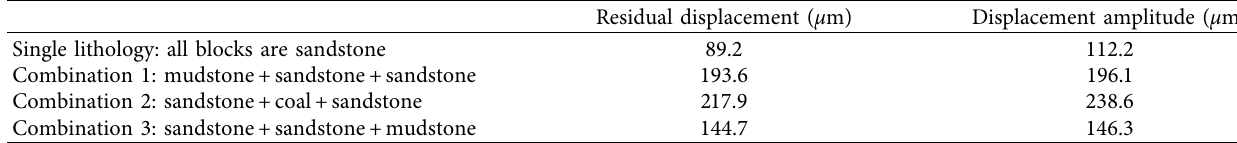
Table 6: Horizontal residual displacement and displacement amplitude of the working block under different lithology.